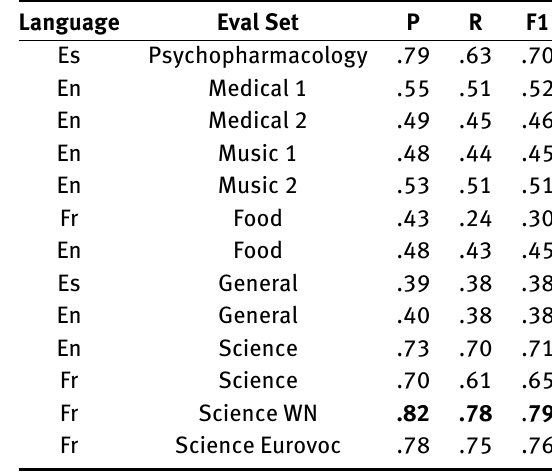
Table 2: Evaluation results of the population algorithm using Dataset